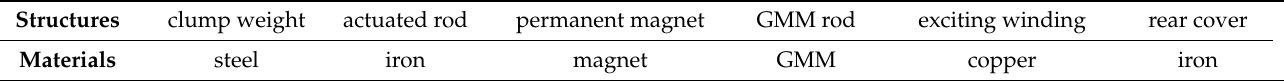
Table 3. Corresponding table between structures and materials.